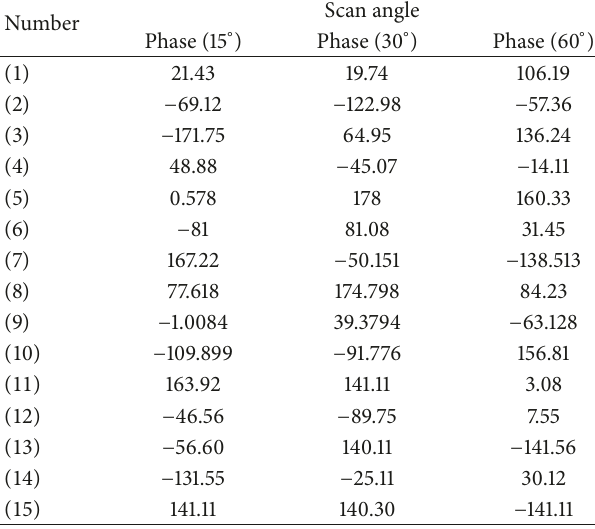
Table 2: Optimized K-band antenna array feed phase